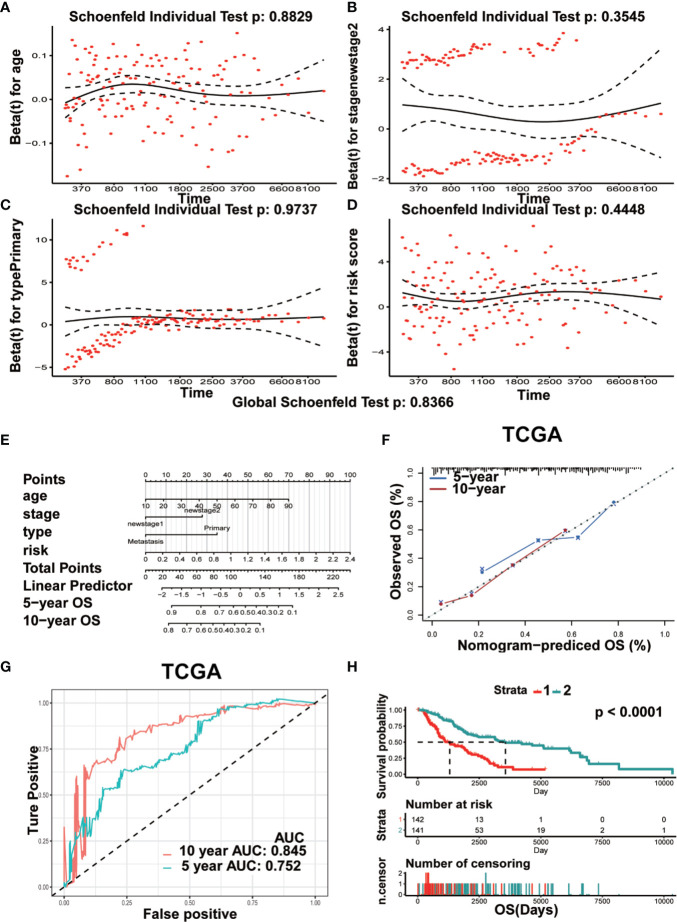
Prognostic nomogram model was constructed for predicting OS. (A–D) The plots of Schoenfeld residual were showed for age (A) stage II (B) Primary (C) risk (D) in the prognostic nomogram. (E) The prognostic nomogram for melanoma patients was established dependent on four crucial factors. (F) The calibration curve of OS predicted by nomogram. The predicted possibility of OS is responded to x-axis and the observed OS is responded to the y-axis. (G) The curve of ROC based on the prognostic nomogram at 5-year and 10-year OS. (H) Comparison of OS between two groups (Strata 1 vs Strata 2).